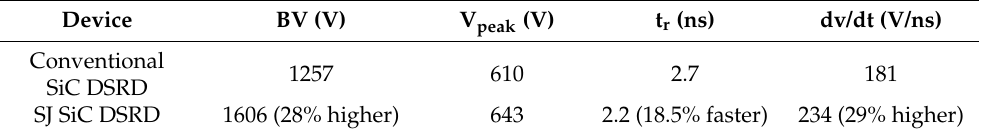
Table 1. Comparison of parameter characteristics between conventional SiC DSRD and SJ SiC DSRD.